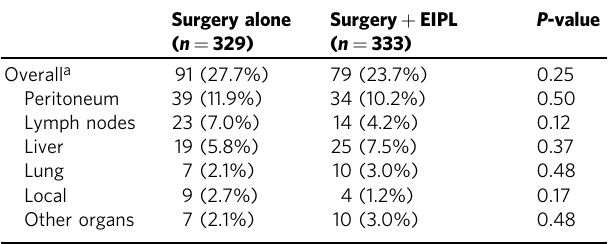
Table 2 Site of fi rst tumor recurrence. Table 1 Demographics and baseline